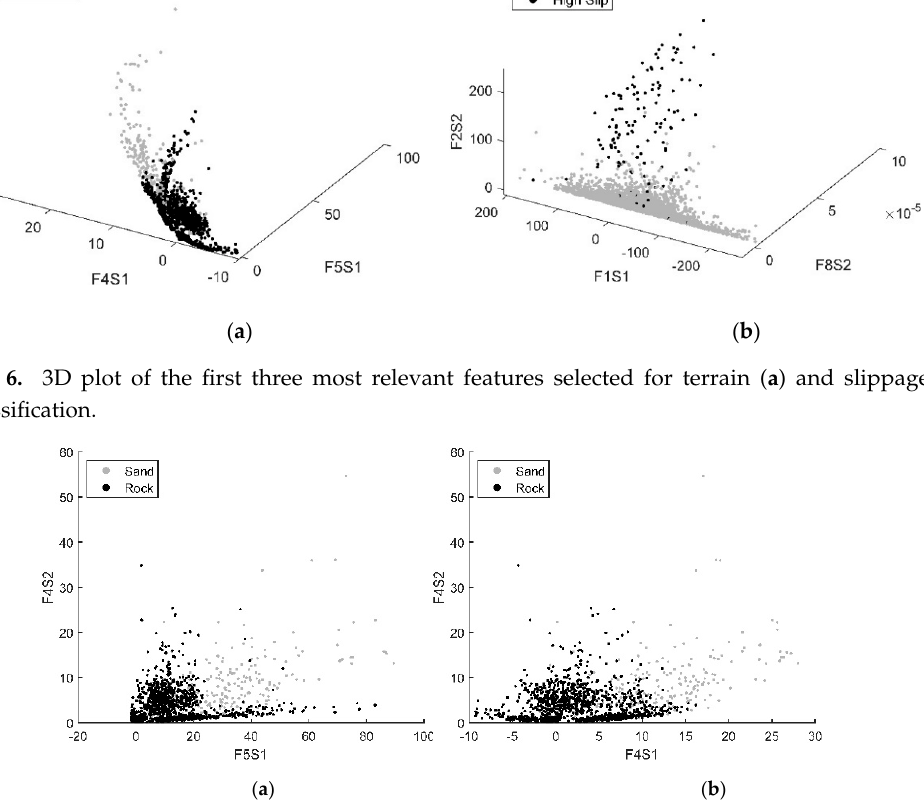
Table 7. Performance metrics of the terrain classifier.